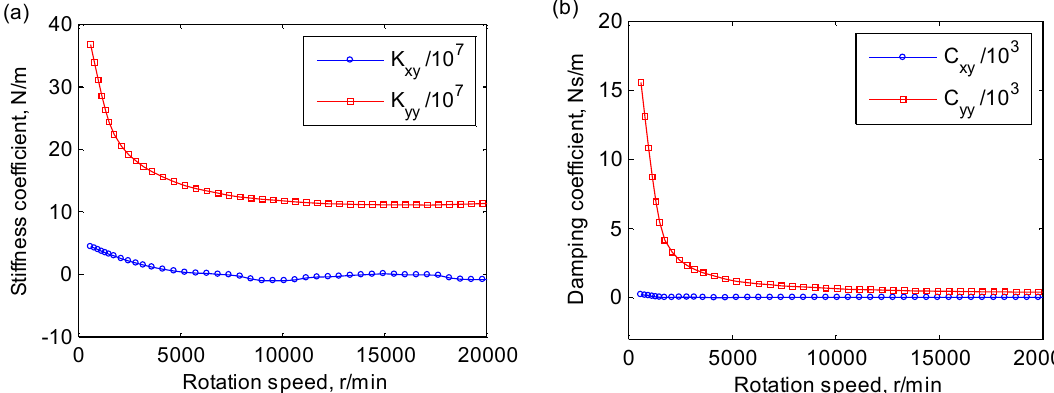
Figure 9. The speed-dependent coefficients of a journal bearings versus the rotating speed: ( a ) stiffness coefficients, ( b ) damping coefficients.